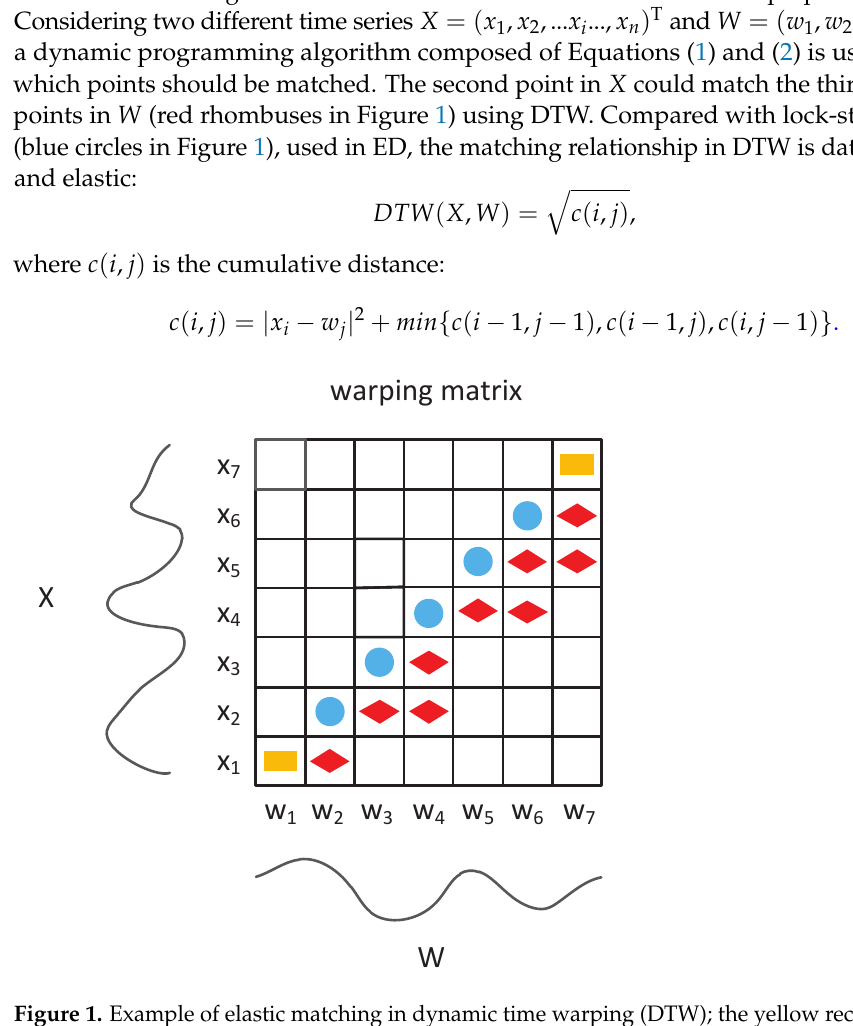
Figure 1. Example of elastic matching in dynamic time warping (DTW); the yellow rectangles are the beginning and end of the two paths; blue circles and red rhombuses represent the optimal paths in Euclidean distance and DTW,